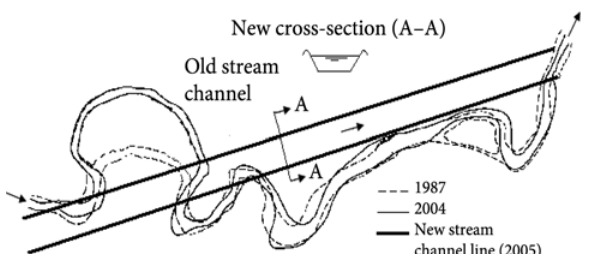
Fig. 13. Cross-section and flow line modification after flood event in Goksu dowstream